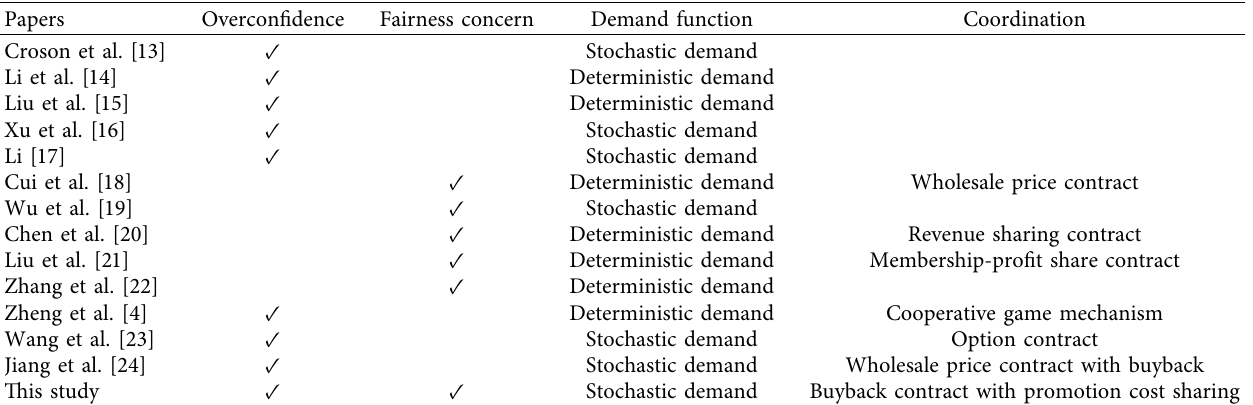
Table 1: Differences between this paper and relevant